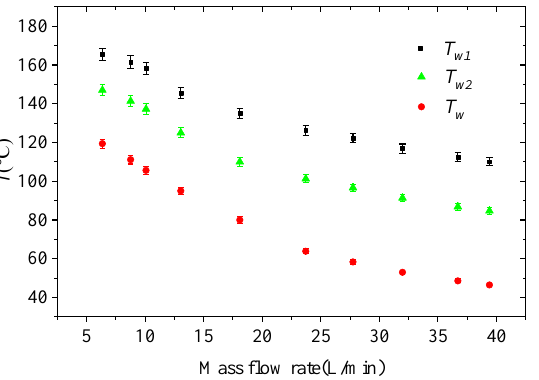
Figure 8. The relationship between the average wall temperature and the flow rate